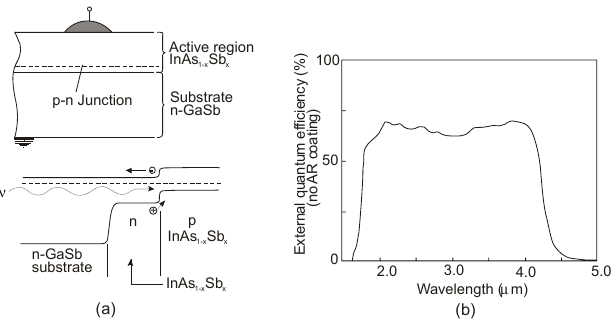
Figure 33. BSI InAs 0.86 Sb 0.14 /GaSb photodiode: ( a ) device structure and energy-band diagram of the structure, ( b ) spectral response at 77 K (after [9]).